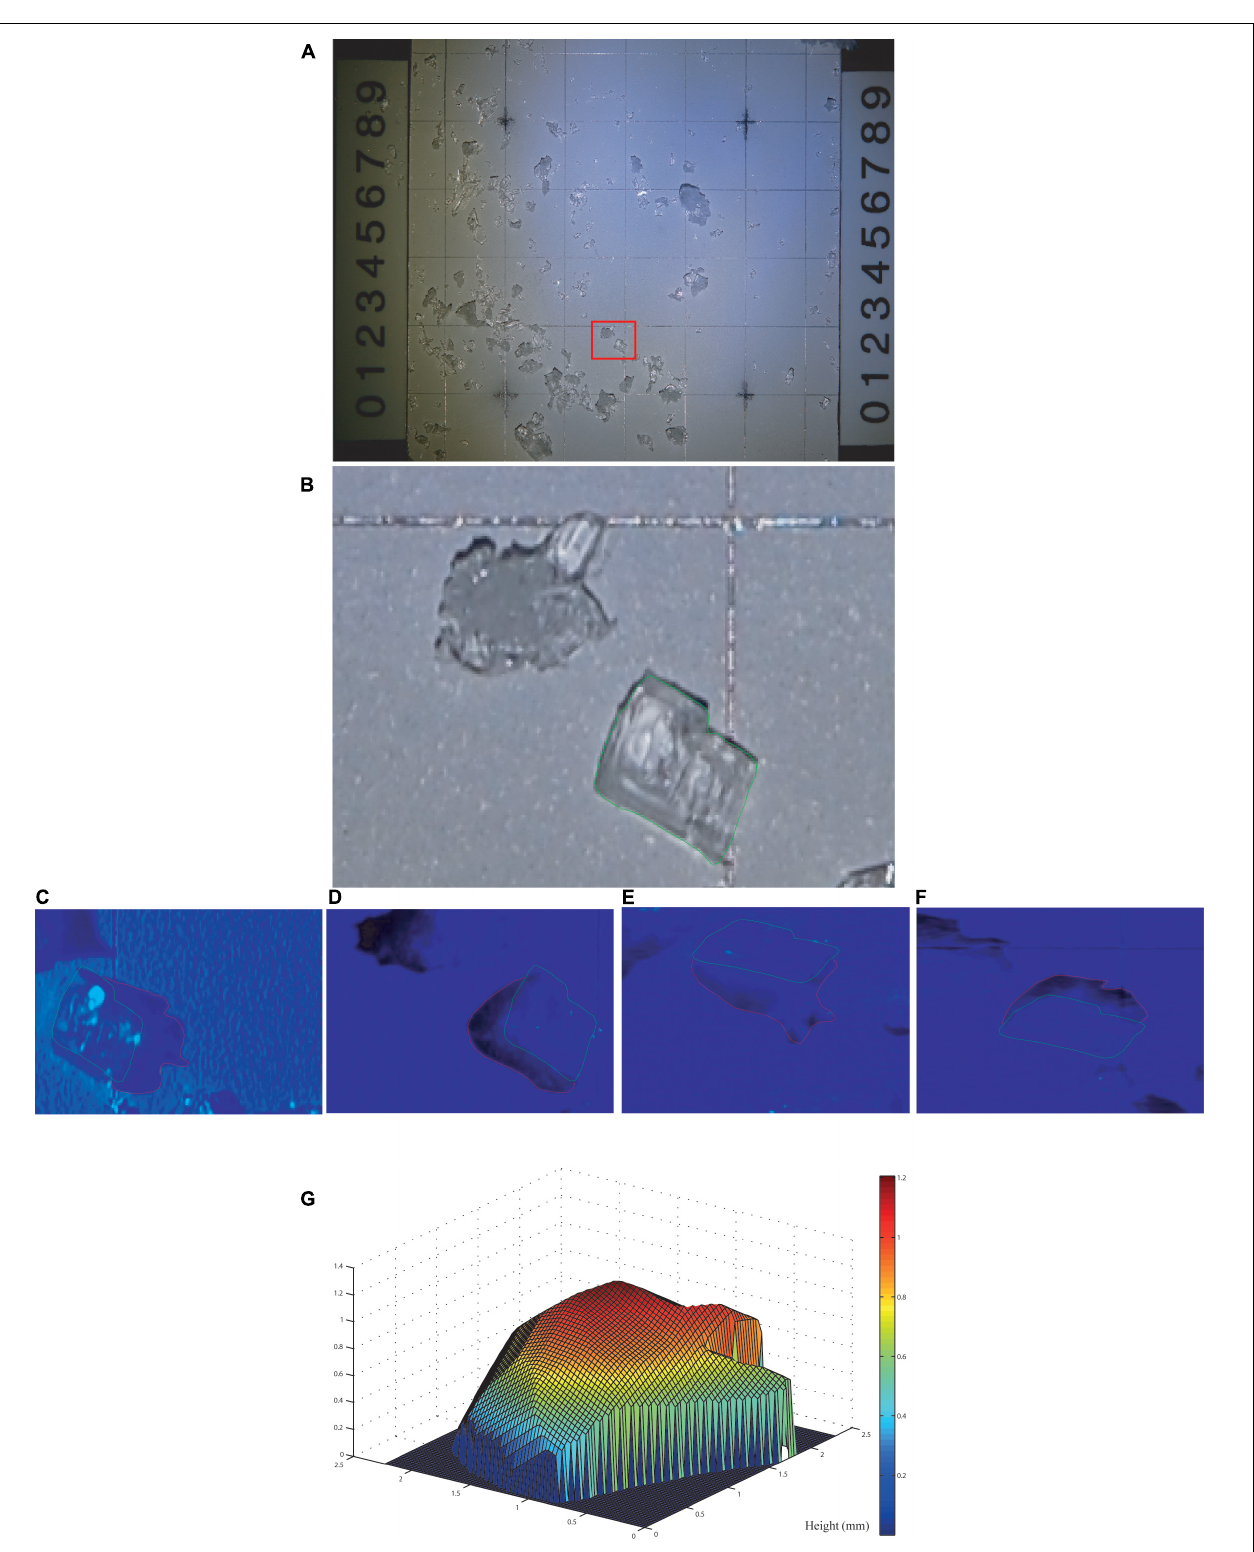
FIGURE 1 | Illustration of the different steps to compute snow grain metrics from the dLED. The two photographs at the top (A,B) represent the process of selecting a single grain, and the bottom four photographs highlight the projected shadow digitization (C–F) for a 3D reconstruction (G) of each individual grain.